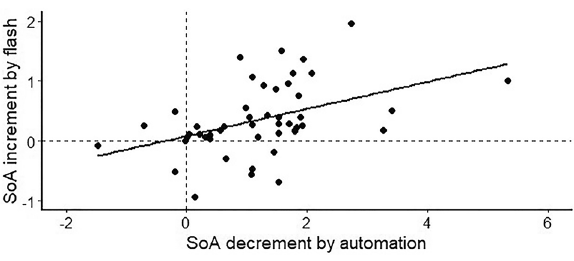
Figure 2. The correlation between SoA decrement by automation and SoA increment by the flash. Each dot indicates the data of one participant. The black line indicates the result of linear